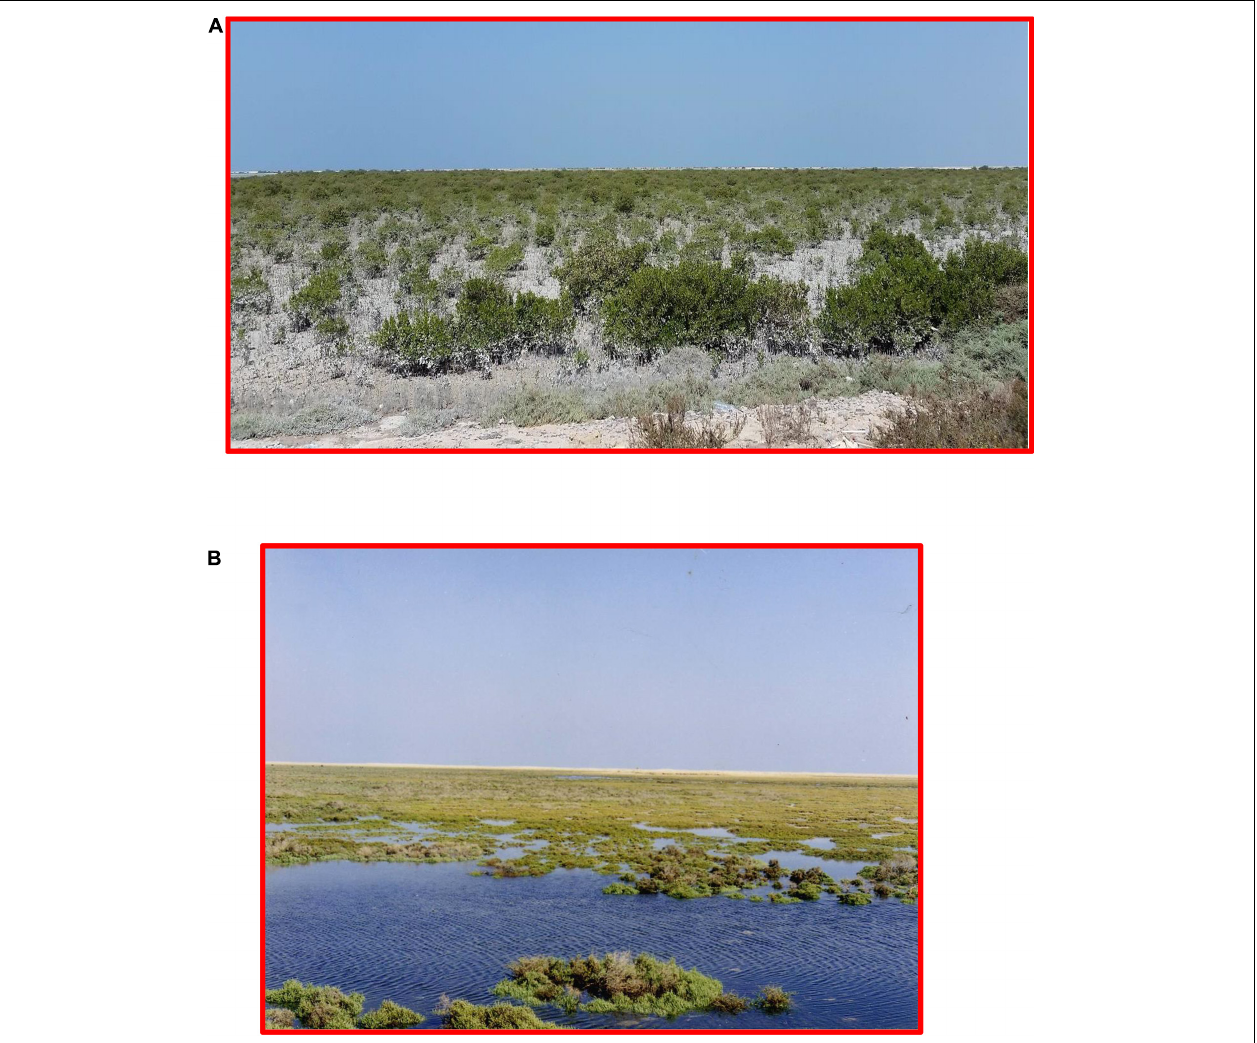
FIGURE 3 | Mangrove forests and halophytes at Al-Dhakhira. (A) Heavy traces of salts at the phyllosphere parts of Avicennia marina plants at low tides. (B) Dense growth of halophytic plants in a Sabkha seen at high tide.